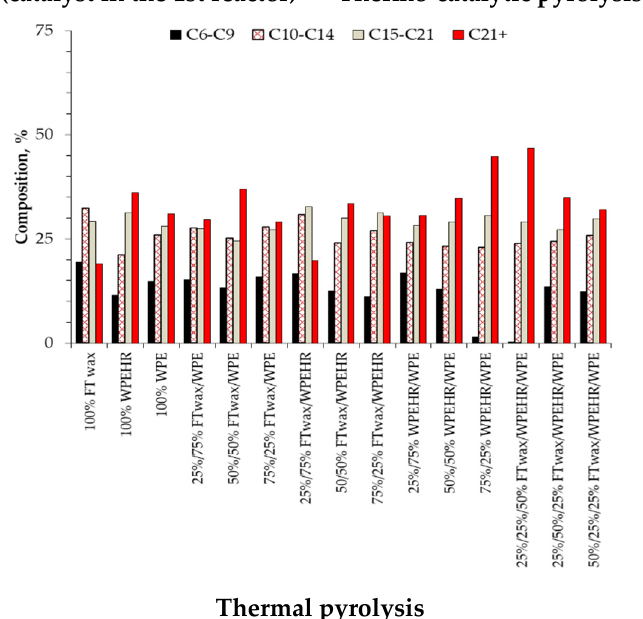
Figure 4. Composition of pyrolysis liquid products.